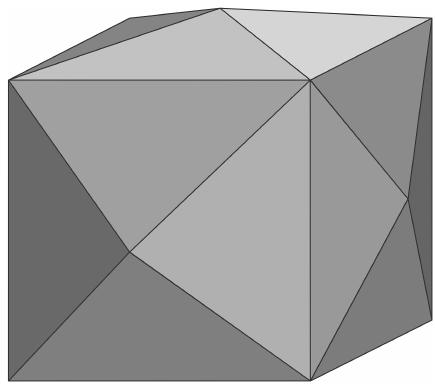
Figure 3. Drawing of a { 410 } tetrahexahedral cubic crystal: each face is an isosceles triangle, and the faces form pyramids, the bases of which are the { 100 } square faces of a